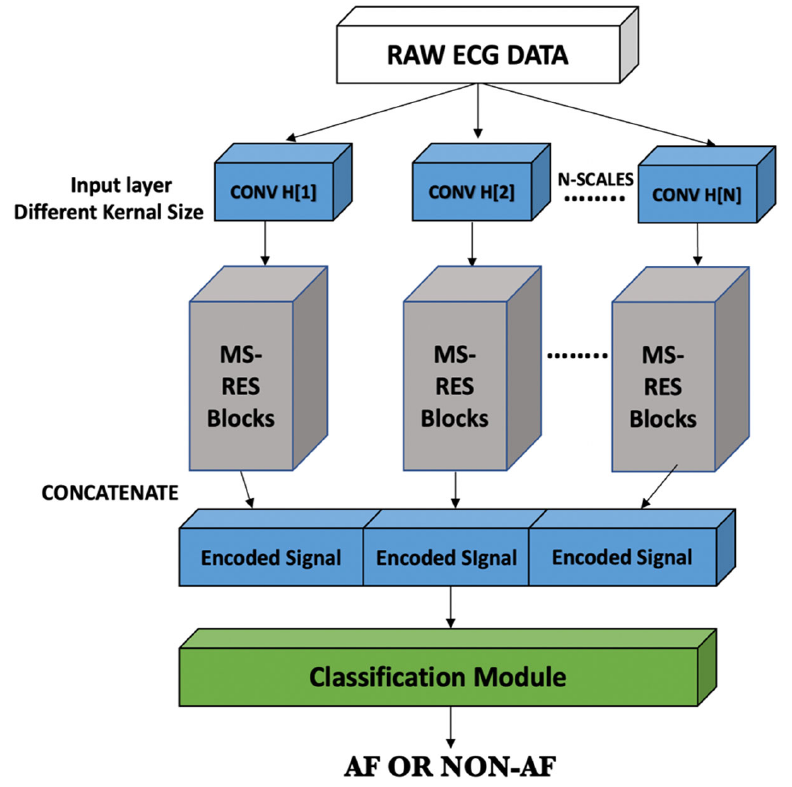
Figure 2. The proposed network architecture of the MsRes.